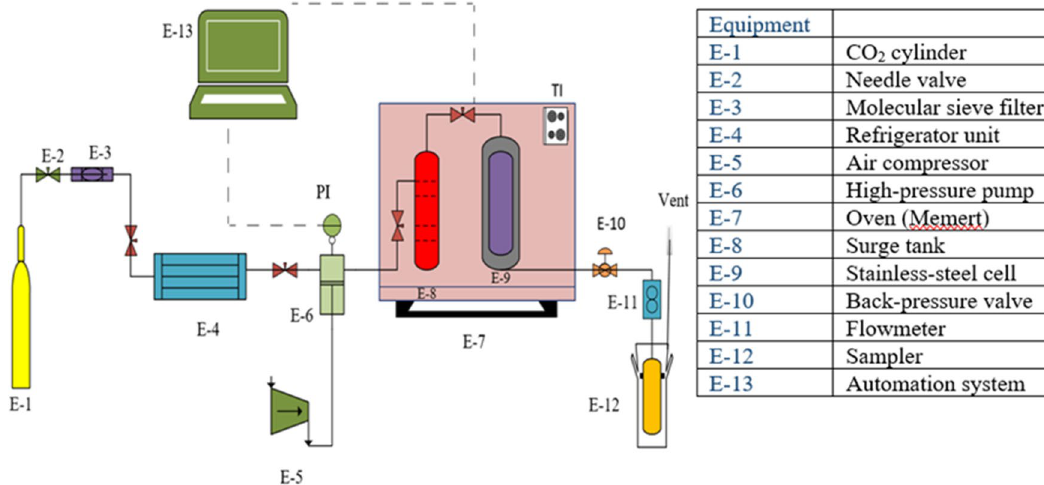
Figure 2. Schematic of Supercritical carbon dioxide extraction.